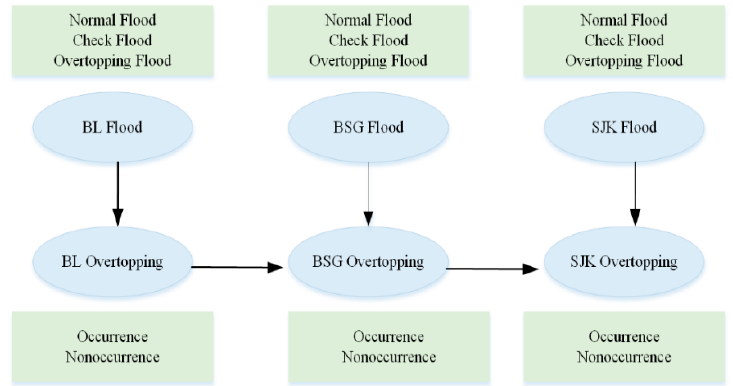
Figure 4. Cascade arrangement situation of BL–BSG–SJK.